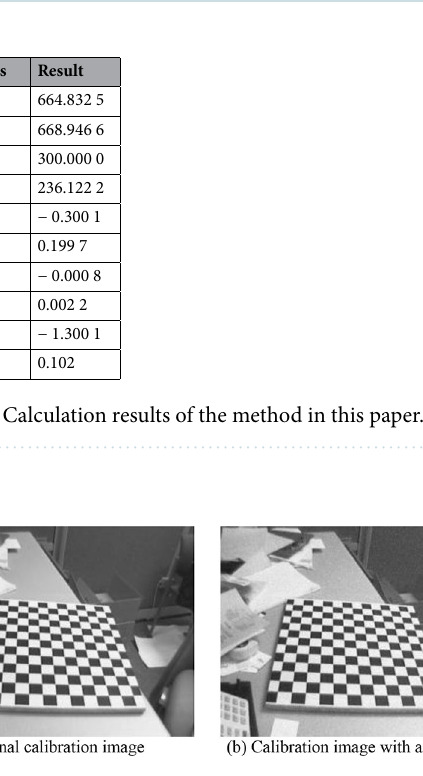
Figure 5. Comparison of the original calibration image and the image with added noise.